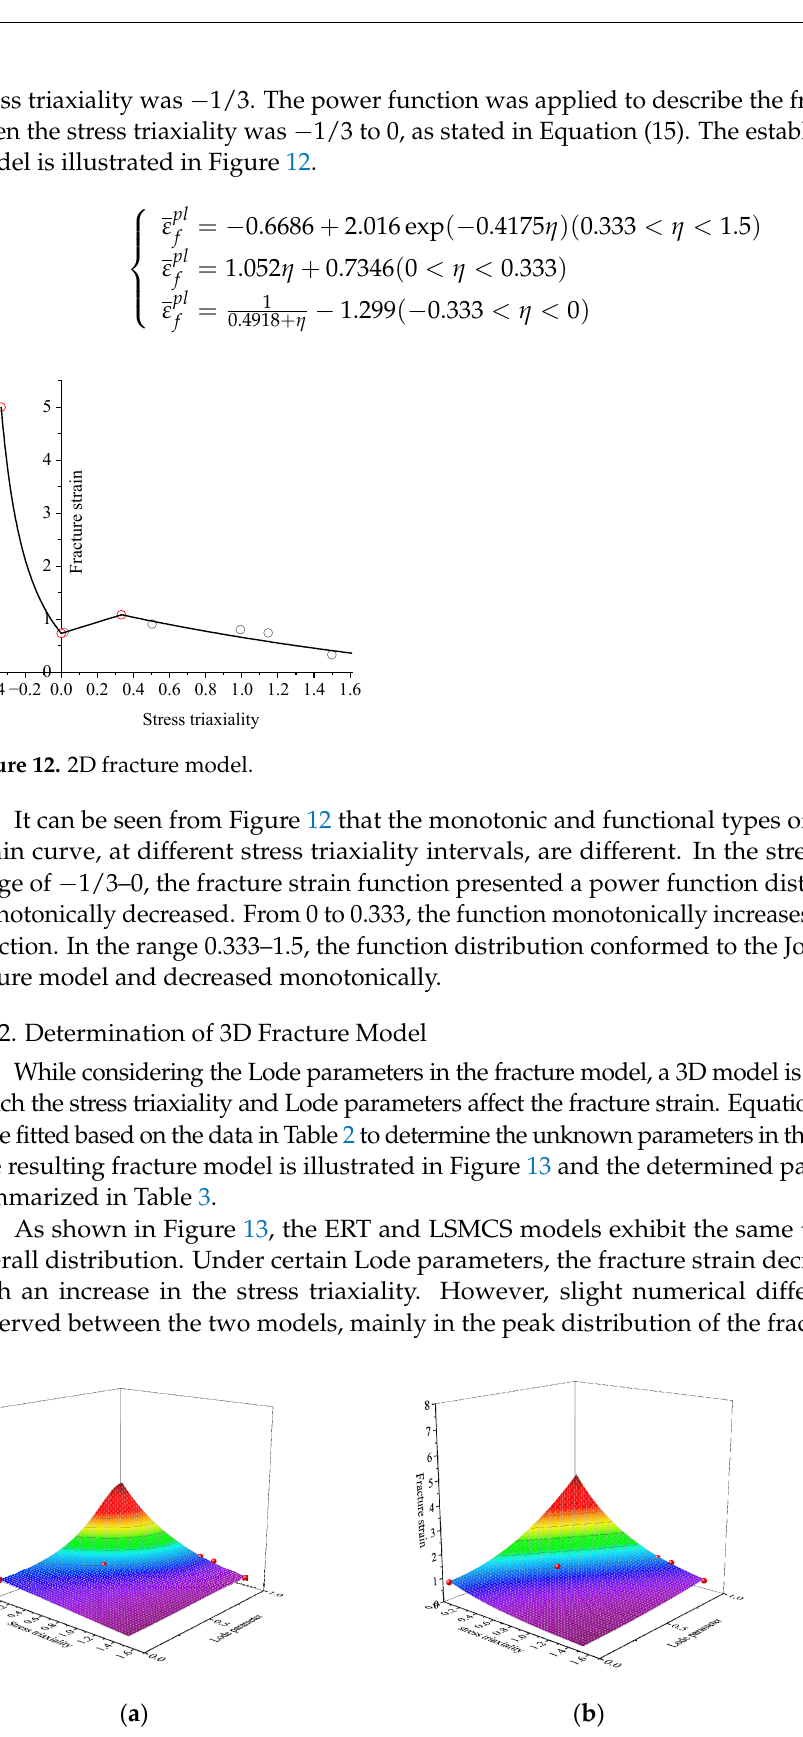
Figure 13. 3D fracture model: ( a ) ERT and ( b ) LSMCS.